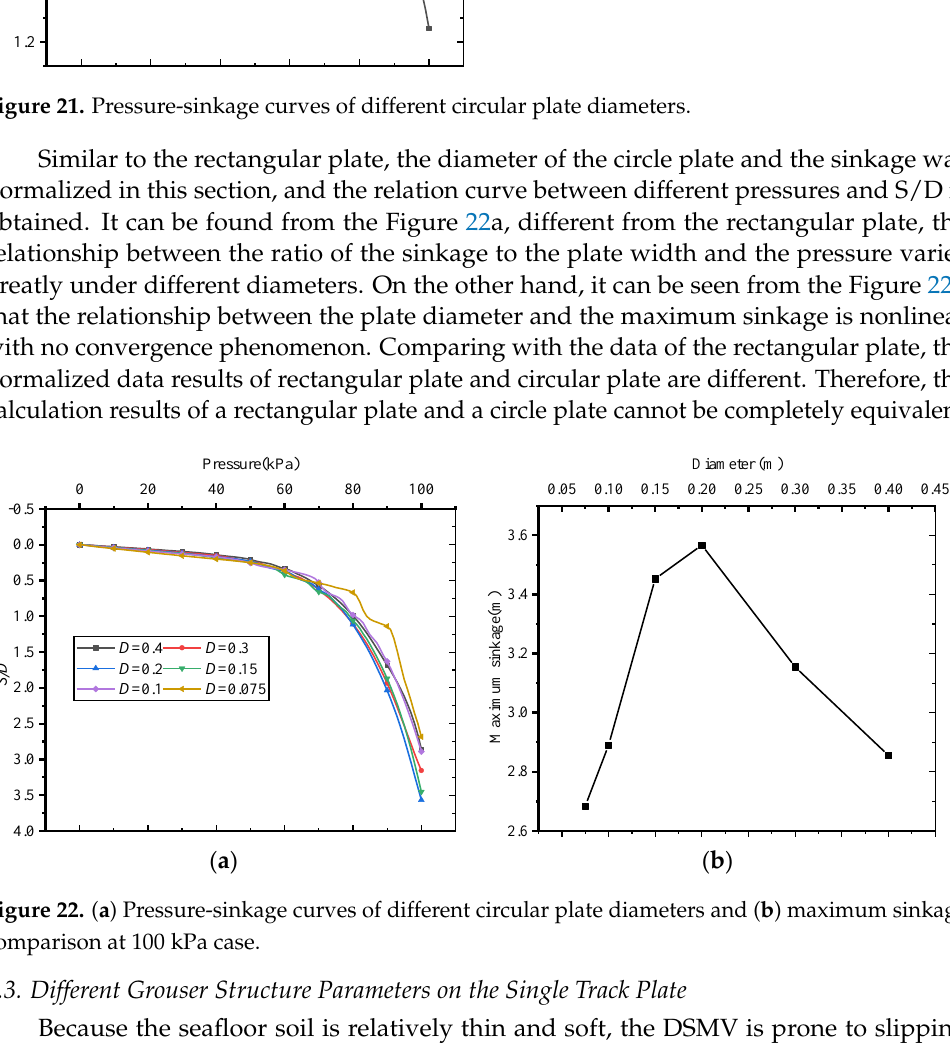
Figure 22. ( a ) Pressure-sinkage curves of different circular plate diameters and ( b ) maximum sinkage comparison at 100 kPa case.